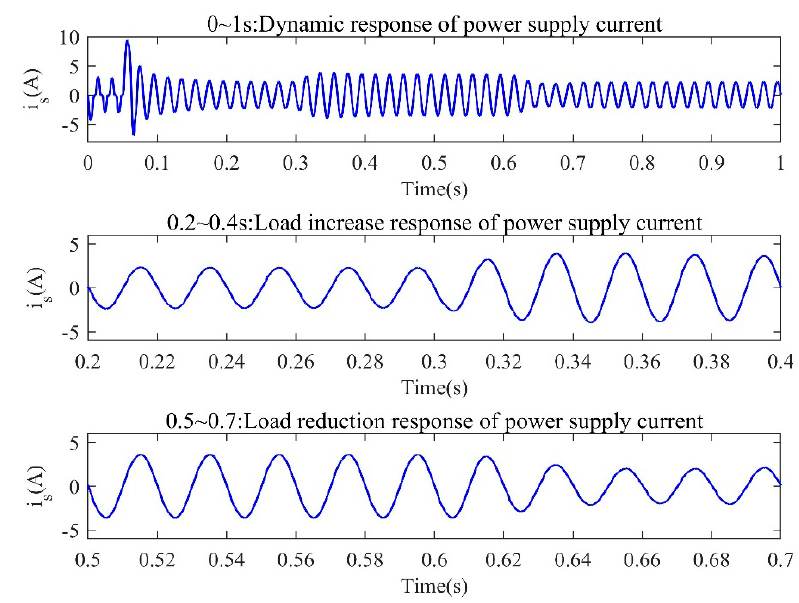
Figure 13. Dynamic response waveforms of power supply current using ASMC − NFNN (load increases at 0.3 s, load decreases at 0.6 s).